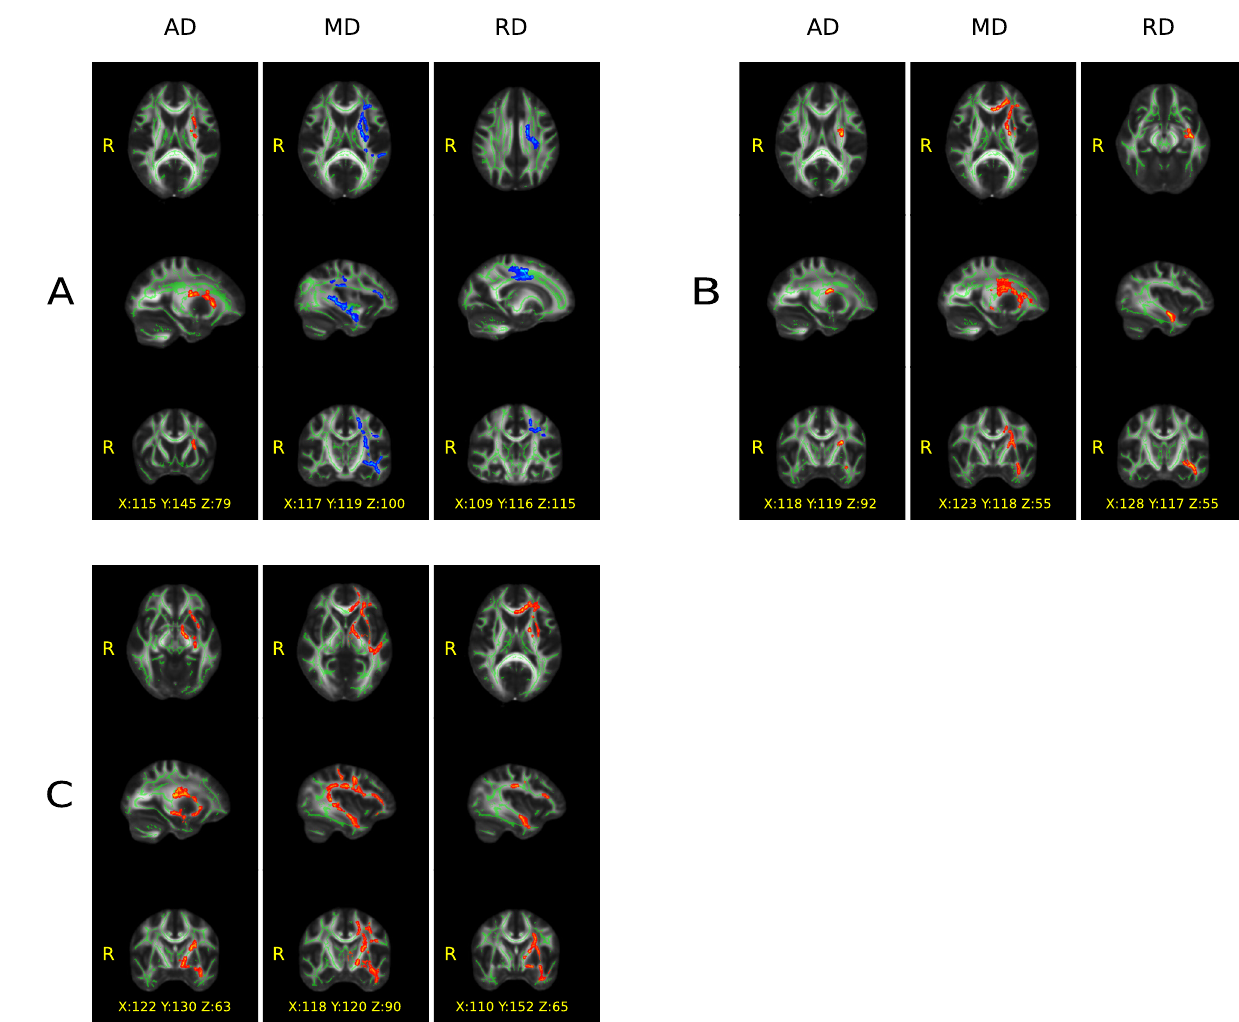
Fig 1. Significant group differences (p < 0.05, corrected) in the white matter revealed by tract-based spatial statistics. A) without flipping, B) after flipping to the left and C) to the right side. Color code: red = increased, blue = decreased diffusion parameters in the Parkinson patients compared to the healthy subjects; green = skeleton of the white matter tracts. AD = axial, MD = mean and RD = radial diffusion. MNI coordinates of the voxel showing the highest significance is provided on the figure.